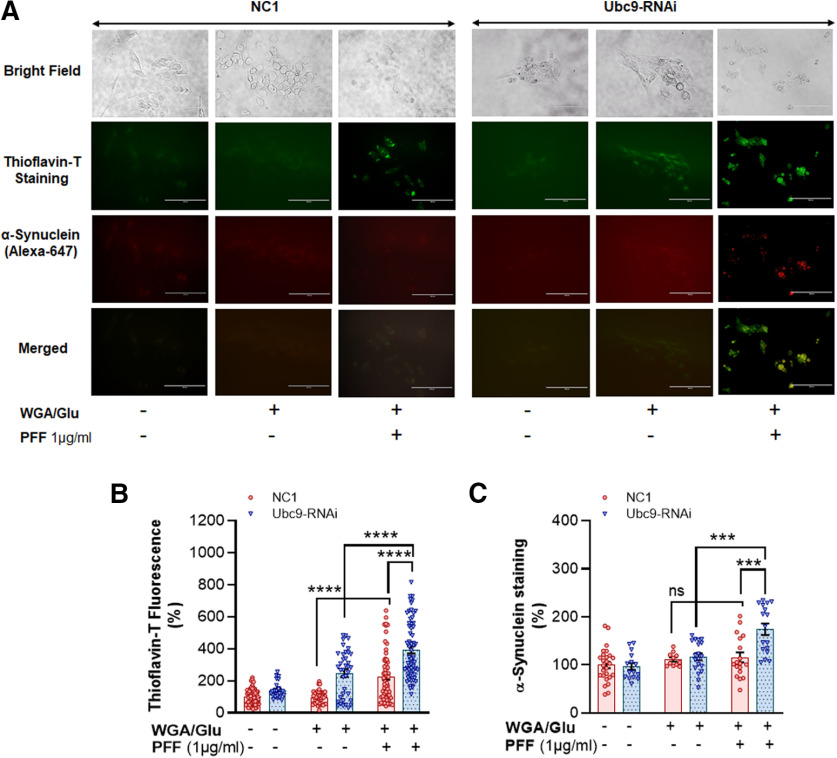
Ubc9 knock-down by RNAi exacerbates PFF-induced protein aggregation in thioflavin T staining. A, Bright field images show the location of N27 cells (top row). Immunocytochemical images of thioflavin T staining in dark field show PFF-induced protein aggregation in green fluorescent label (second row). α-Syn staining (red) in immunocytochemistry was detected in thioflavin T -labeled protein aggregates (third row). The merged images (yellow, the bottom row) demonstrate that α-syn is co-localized with thioflavin T-stained protein aggregates. B, PFF exposure to N27 cells for 24-h results in the accumulation of protein aggregation labeled in thioflavin T. Ubc9-RNAi further enhances PFF-induced protein aggregation, compared with NC1 random cocktail control with WGA/GluNAc. C, PFF increases the level of α-syn in thioflavin T-positive aggregates with Ubc9-RNAi, and Ubc9 knock-down aggravates α-syn accumulation in the protein aggregates compared with NC1 control after PFF treatment, although PFF did not significantly increase the level of α-syn in the aggregates in NC1 control-treated cells. Integrated density of images was measured by ImageJ and presented in scattered dot plots. Statistical analysis was performed using two-way ANOVA followed by Tukey’s multiple comparisons post hoc test. All dot plots were displayed as individual values and mean differences are depicted as horizontal lines; SEM is indicated by the end of the vertical error bars; ***p < 0.001, ****p < 0.0001; ns: not significant (n = 24–40 per group). Scale bar: 100 μm.